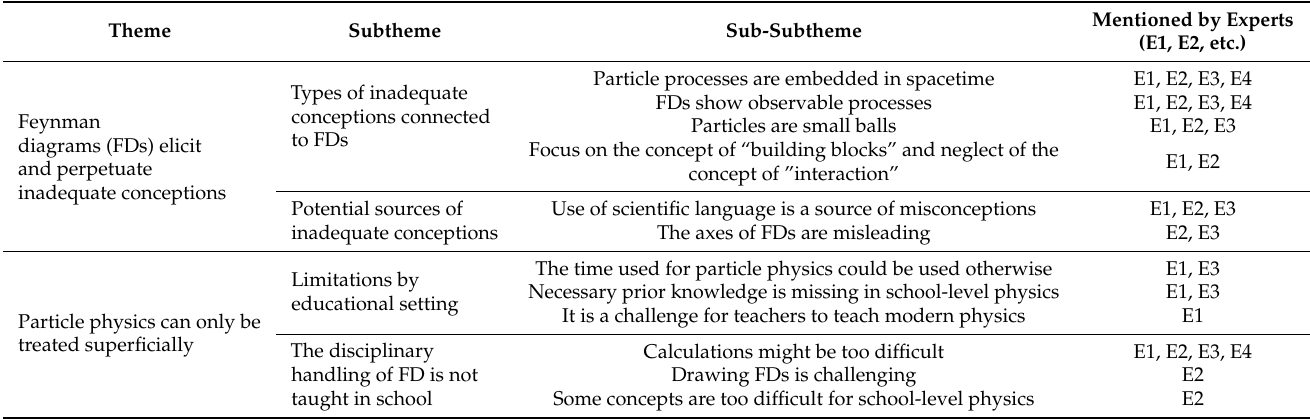
Table 1. Themes and subthemes of the dimension challenges. The order of the (sub-)subthemes within a (sub)theme is according to the frequency of